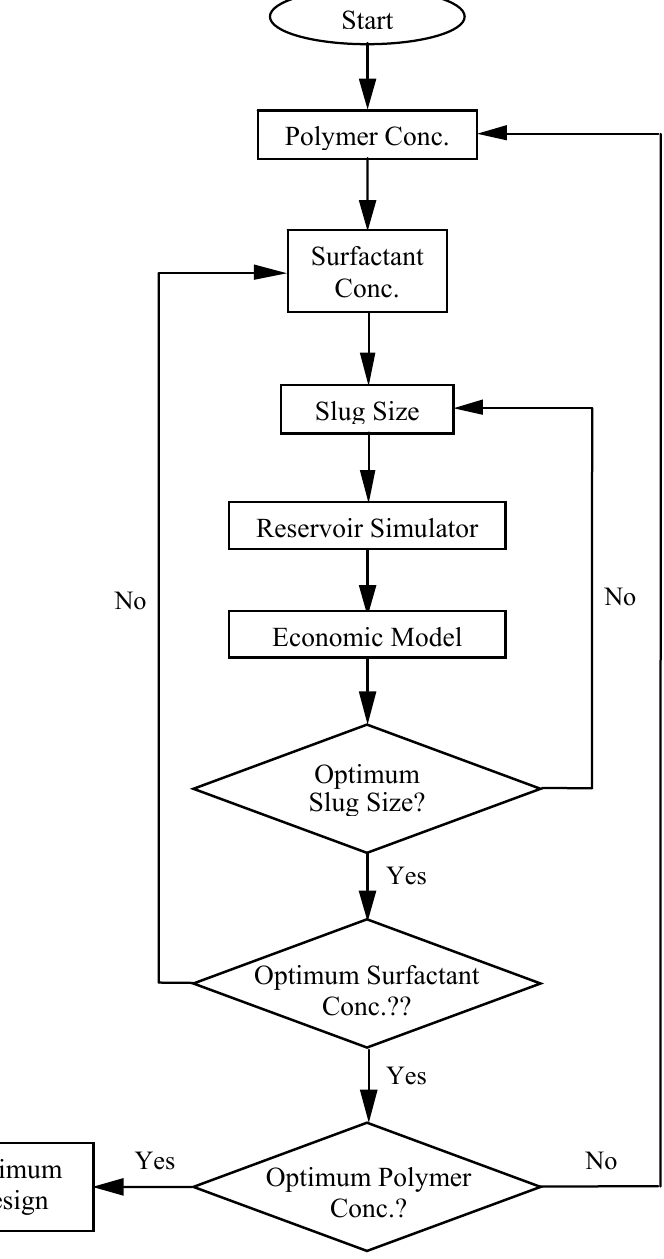
Figure 1. Optimization process used for surfactant/polymer